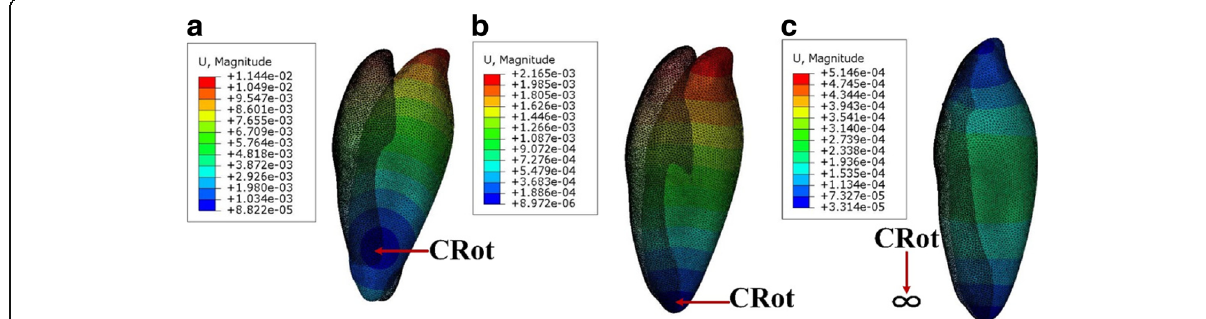
Fig. 2 Several types of tooth deformation enlarged by a factor of 500, the force systems applied in buccal-lingual direction. a Uncontrolled tipping(M/F = 0). b Controlled tipping(M/F = 6.4). c Pure translation (M/F = 10.6)